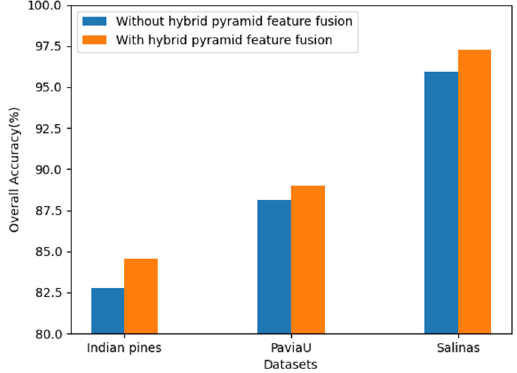
Figure 17. The influence of the hybrid pyramid feature fusion mechanism.